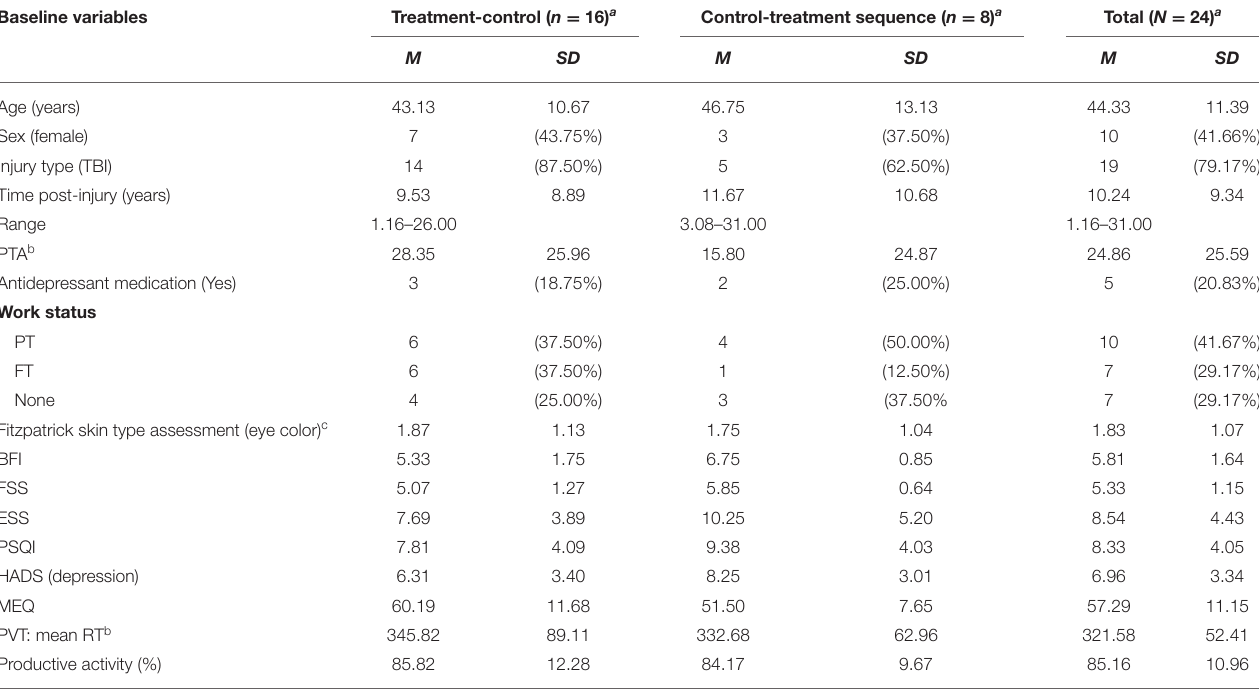
TABLE 1 | Demographic and clinical characteristics by treatment sequence at baseline. Baseline